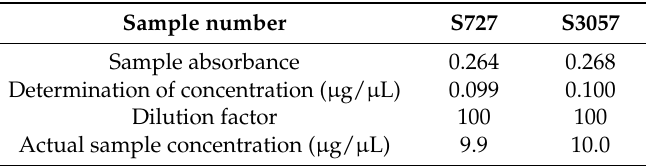
Table 2. Sample Bradford quantitative